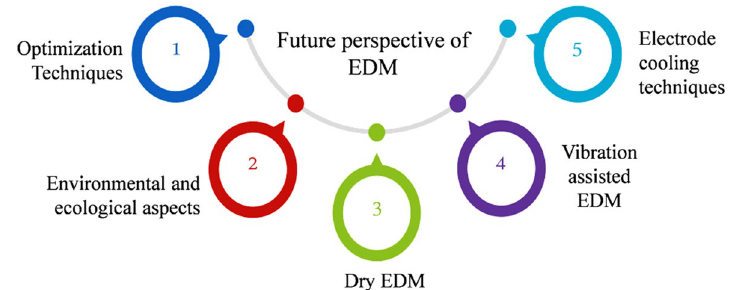
Fig. 11 Future research directions for the